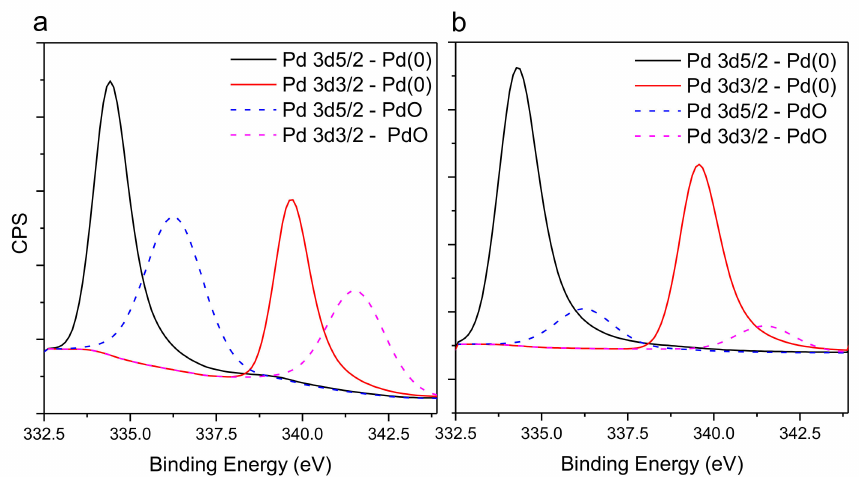
Figure 5. High-Resolution X-ray Photoelectron Spectroscopy (XPS) Spectra for 0.25 wt% Pd–TiO 2 : ( a ) Before photoreduction and ( b ) After photoreduction. Note: Continuous lines represent Pd ◦ at (i) 3d5 / 2 and (ii) 3d3 / 2. Broken lines represent PdO at (iii) 3d5 / 2 and (iv) 3d3 / 2.